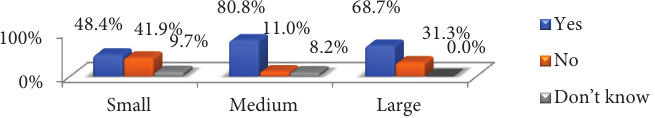
Figure 1. Use of cost controlling in the enterprises